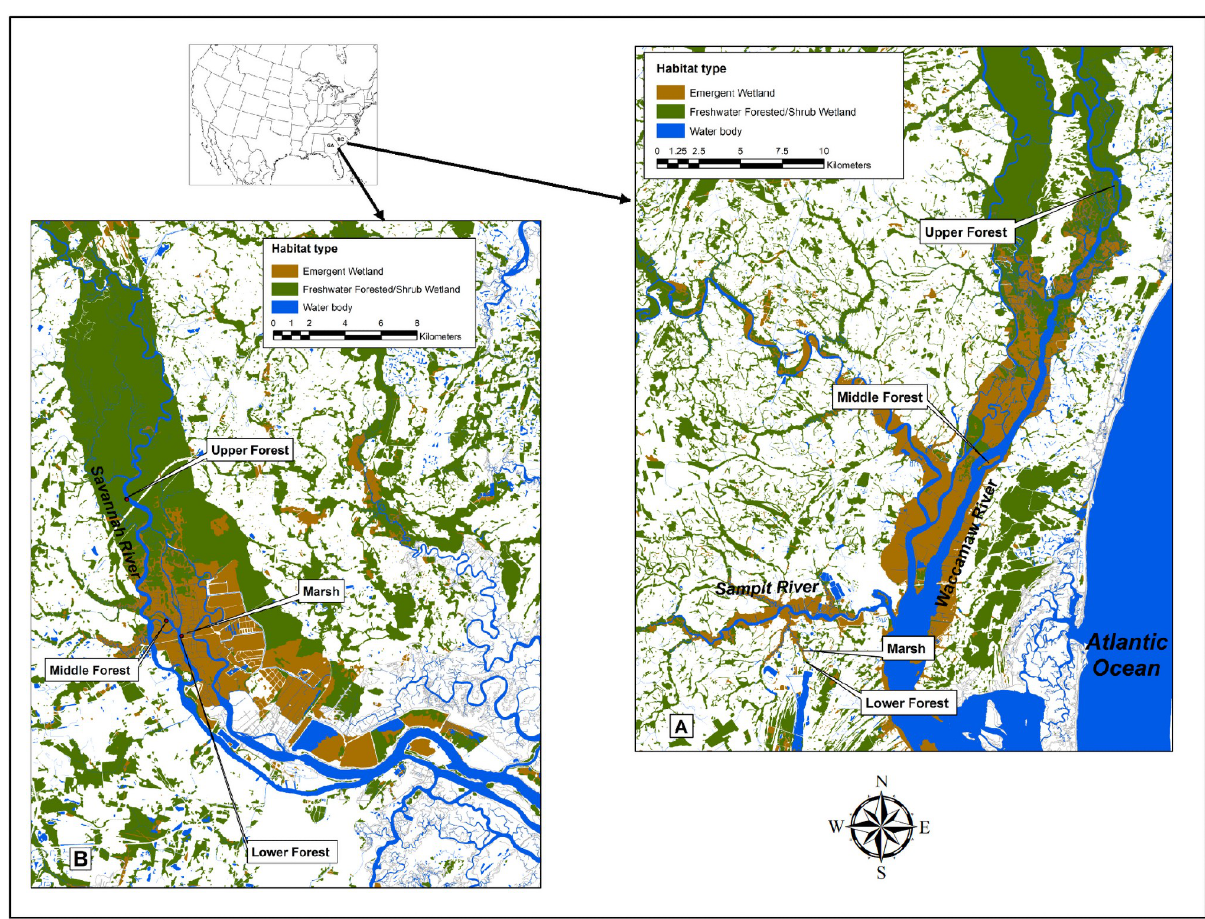
Fig 1. Location of study sites along the Waccamaw/Sampit Rivers, South Carolina, and Savannah River, Georgia. Sites represent tidal freshwater forested wetlands (TFFW, Upper Forest), TFFW experiencing low concentrations of salinity incursion (Middle Forest), former TFFW that is undergoing active transition to marsh from salinity intrusion (Lower Forest), and low-salinity herbaceous marsh. Wetland classifications were downloaded at, https://fwsprimary.wim.usgs.gov/wetlands/apps/wetlands-mapper/ (accessed 12 August 2020); however, the freshwater designation was removed from “emergent wetland” because current salinities are above 0.5 psu for much of this emergent wetland area. The image was created using ArcMAP (version 10.7) with the North America political boundaries from ScienceBase (Public Domain) at,